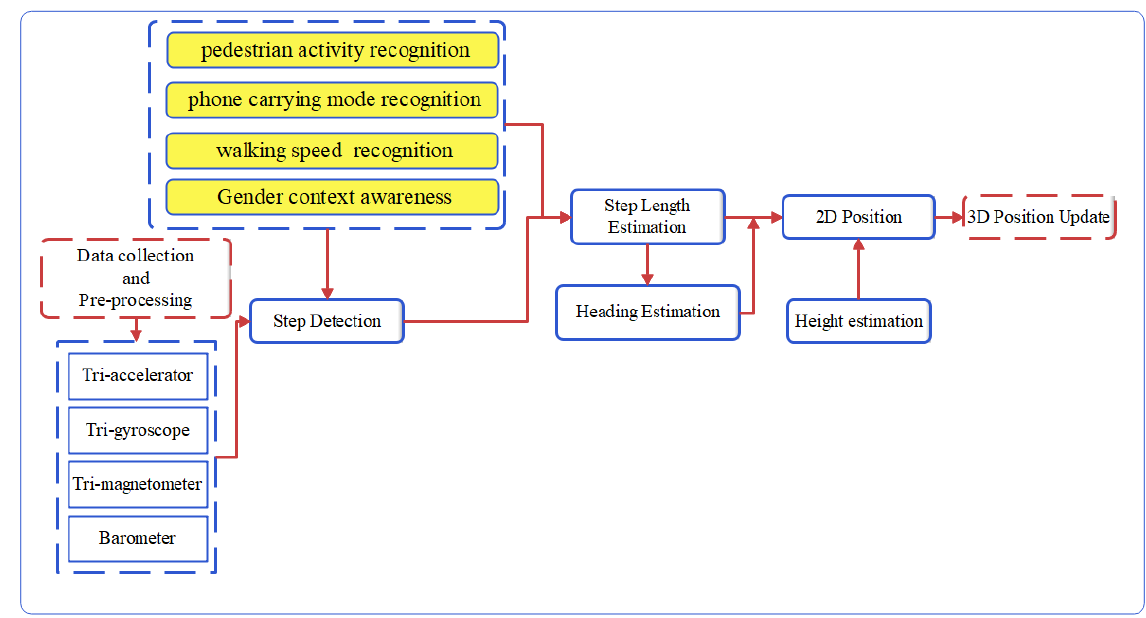
Figure 1. The structure of the proposed PDR